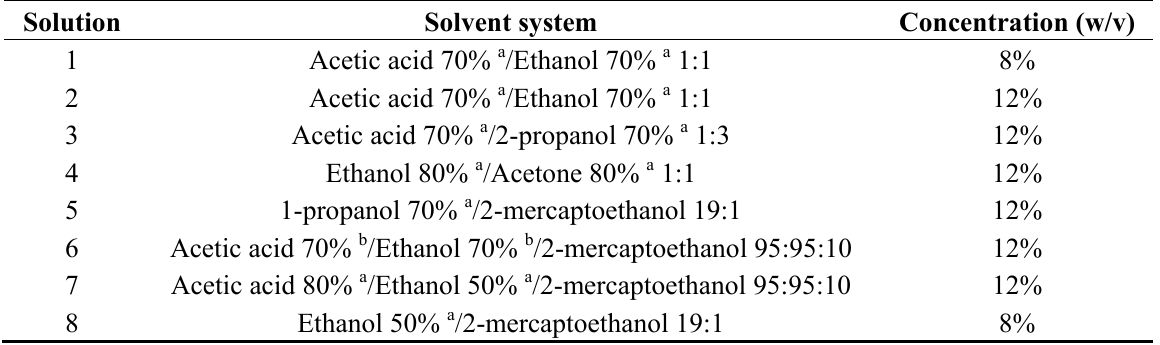
Table 3. Conditions for the preparation of solutions from wheat